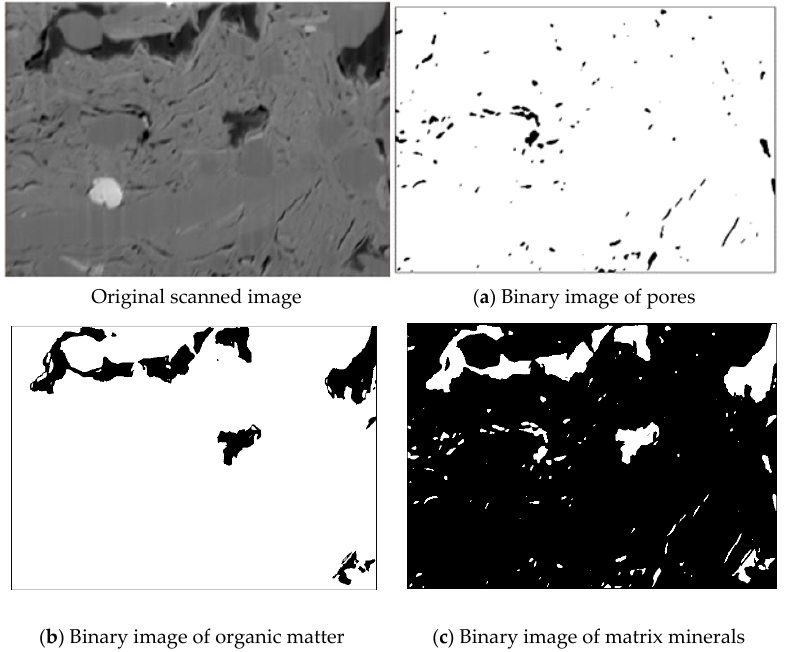
Figure 11. Image segmentation and structure extraction with different compositions.